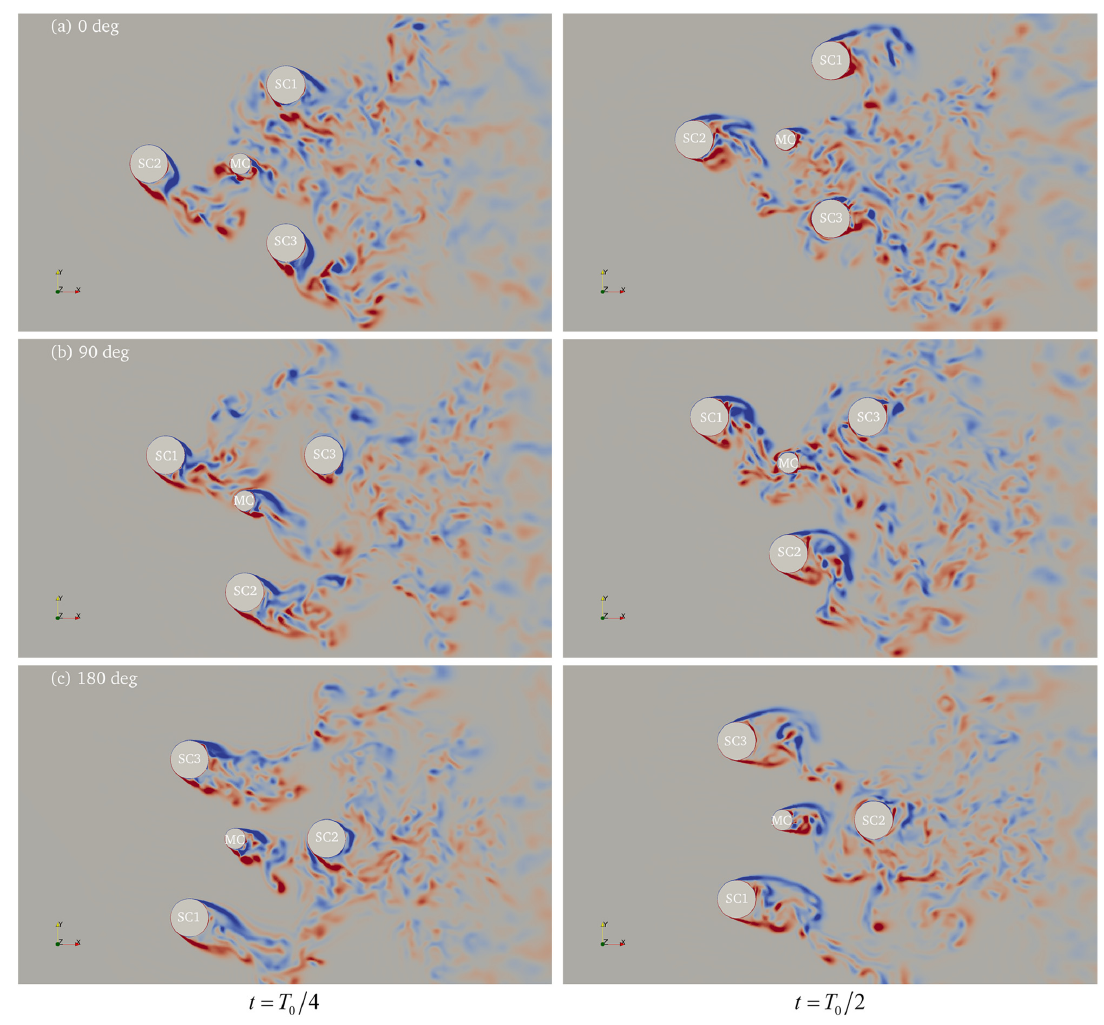
ω on plane of 2 z T = − at two instants for FOWT plat- Figure 21. Contours of axial vorticity Figure 21. Contours of axial vorticity ω z on plane of z = − T /2 at two instants for FOWT platform at z V = under different current incidence conditions. form at 10 V r = 10 under different current incidence r